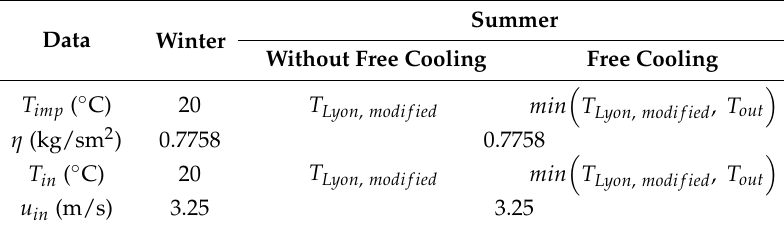
Table 5. Design parameters for Case 2: Energy-efficient